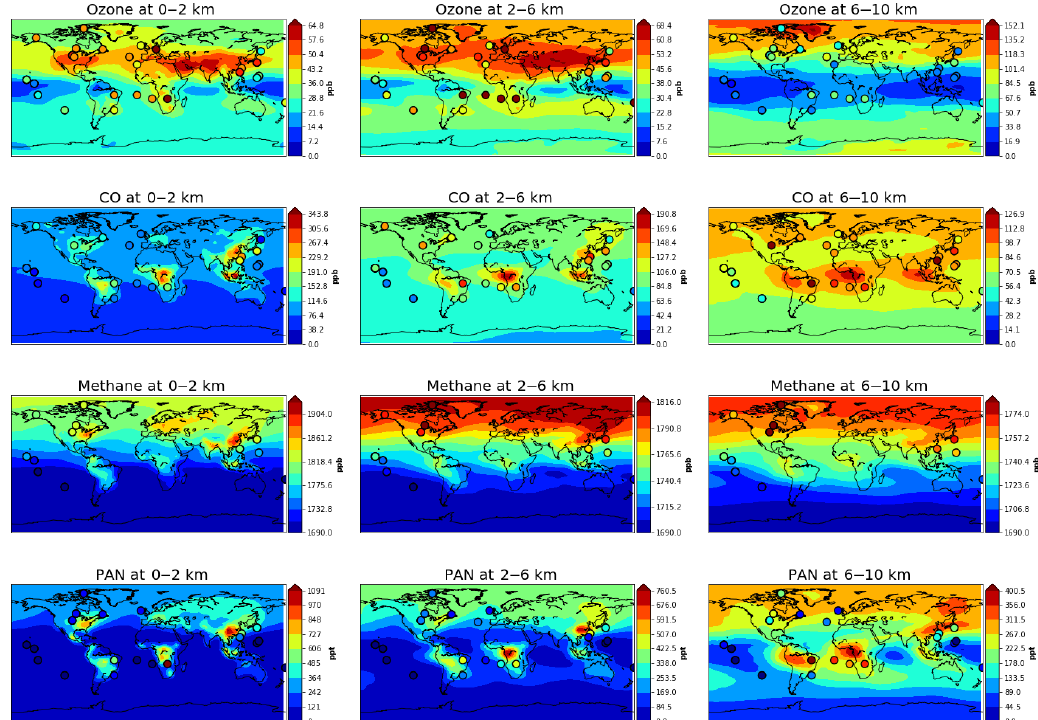
Figure 2. Global mean volume mixing ratios of CO (ppb), CH 4 (ppb) and PAN (ppt) from TOMCAT for the period 1993–2001 at 0–2km (left panels), 2–6km (middle panels) and 6–10km (right panels). The filled circles show mean values from aircraft observation campaigns that took place between 1992 and 2001 (Table S1) (Emmons et al., 2010).